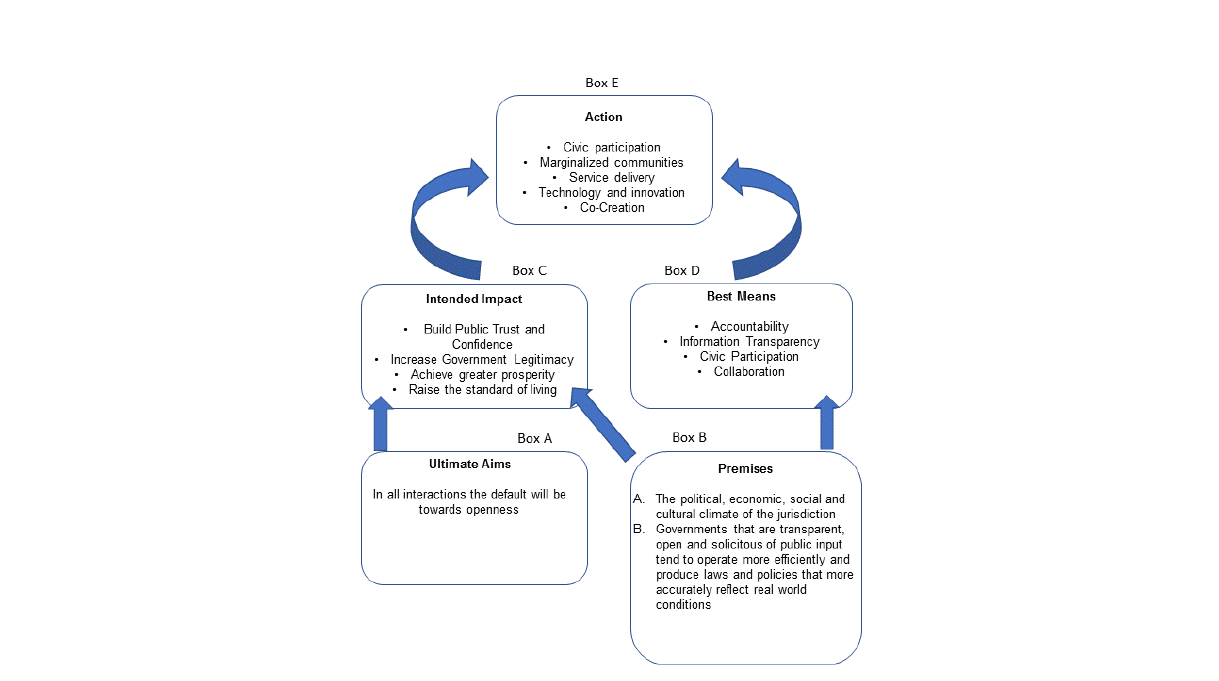
Figure 2: Dialogue Box Framework Populated With Open Government